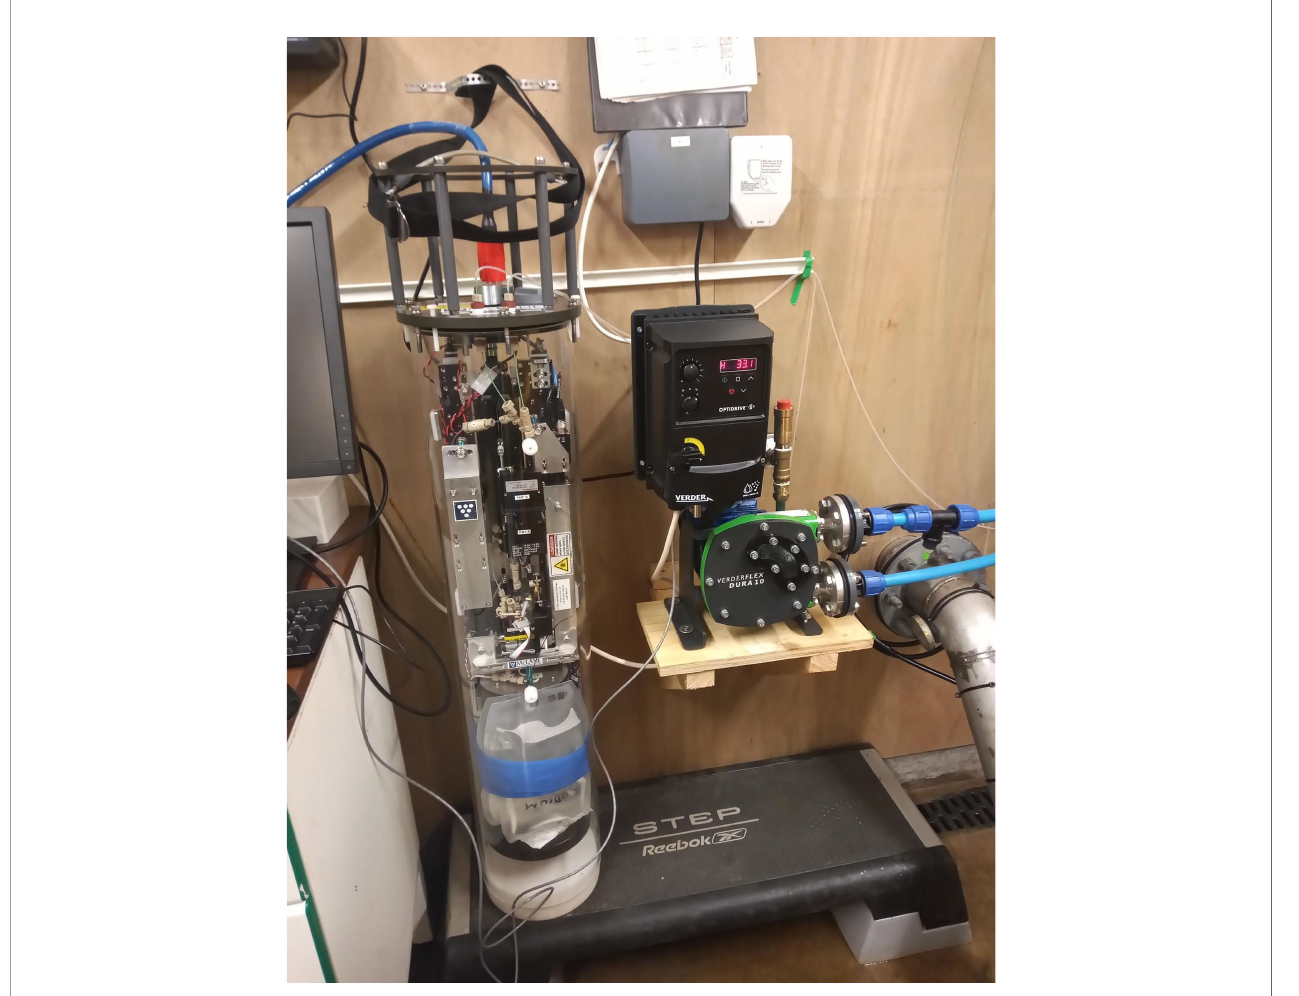
FIGURE 6 | FlowCytoBot (IFCB)deployedin Scalloway inthe Shetland Islands duringPRIMROSE. The IFCB island based with seawater being continuously pumped from an adjacent